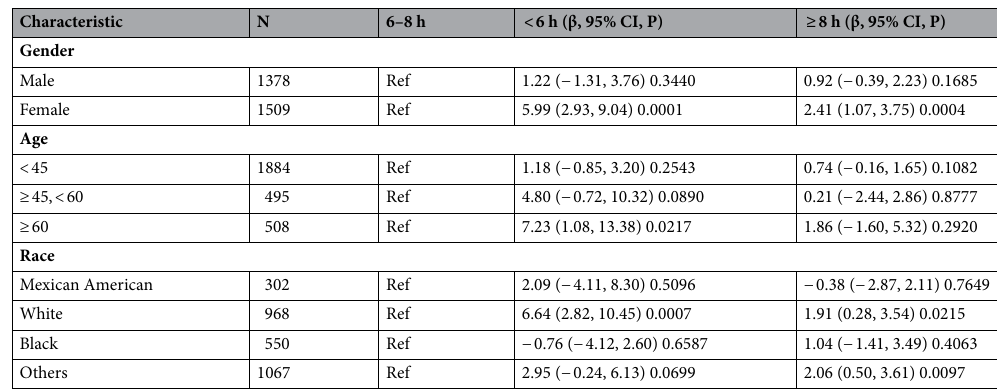
Table 4. Effect size of sleep duration on SBP in each subgroup. Adjusted for: Gender; Age; Race; alcohol; Albumin; Creatinine; Hemoglobin; diabetes; hypertension; snort or stop breathing; smoke; TC; BMI; AST; HDL except the subgroup variable. CI confidence interval, Ref reference, TC total cholesterol, BMI body mass index, AST aspertate aminotransferase, HDL high-density